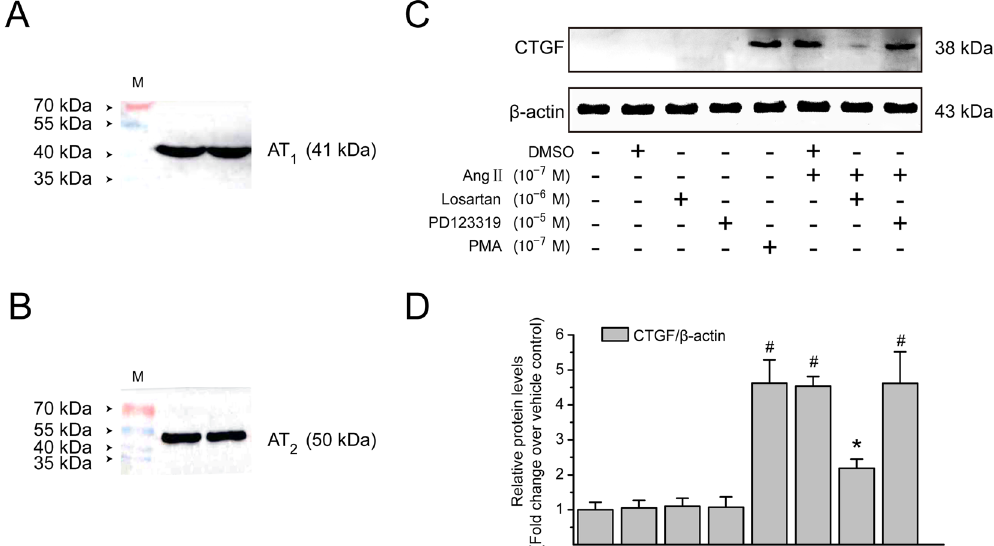
Figure 2. Ang II induces CTGF protein expression via an AT 1 -dependent mechanism in LX-2 cells. ( A,B ) Immunoblotting analysis was performed using whole cell lysates from unstimulated control cells to identify AT 1 and AT 2 . ( C ) Serum-starved LX-2 cells were preincubated with losartan (an AT 1 receptor antagonist; 10 − 6 M) or PD123319 (an AT 2 receptor antagonist; 10 − 5 M) for 1 h and then incubated with or without Ang II (10 − 7 M) for 4 h. PMA (10 − 7 M; a PKC activator) was used as a positive control. Cell extracts were collected and subjected to immunoblotting analysis using anti-CTGF antibody. β -Actin was used as an internal control for equal loading of total protein amounts. The experiments were repeated thrice with similar results and representative immunoblot bands are shown. ( D ) The protein levels of CTGF were converted to arbitrary densitometric units, normalized by the value of β -actin and expressed relative to the level of CTGF in the vehicle-treated cells (defined as 1-fold). The results are shown as mean ± SD of 3 independent experiments. # P < 0.05 versus vehicle- treated control cells; * P < 0.05 versus Ang II-treated